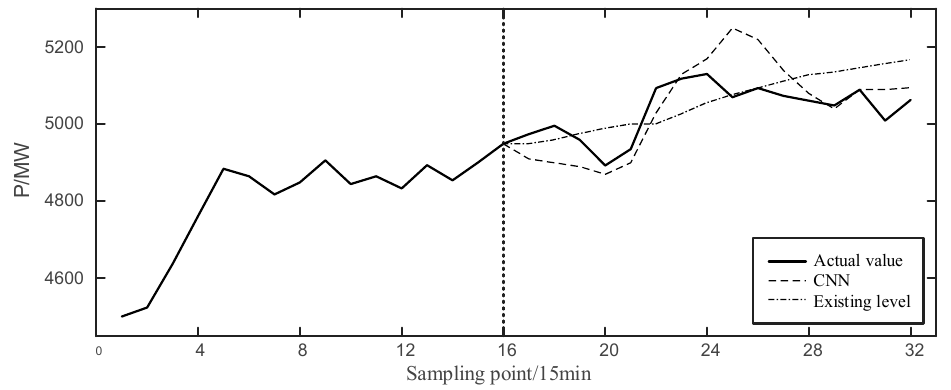
Figure 5. CNN prediction result at 0:00–4:00 on 6 November 2019.